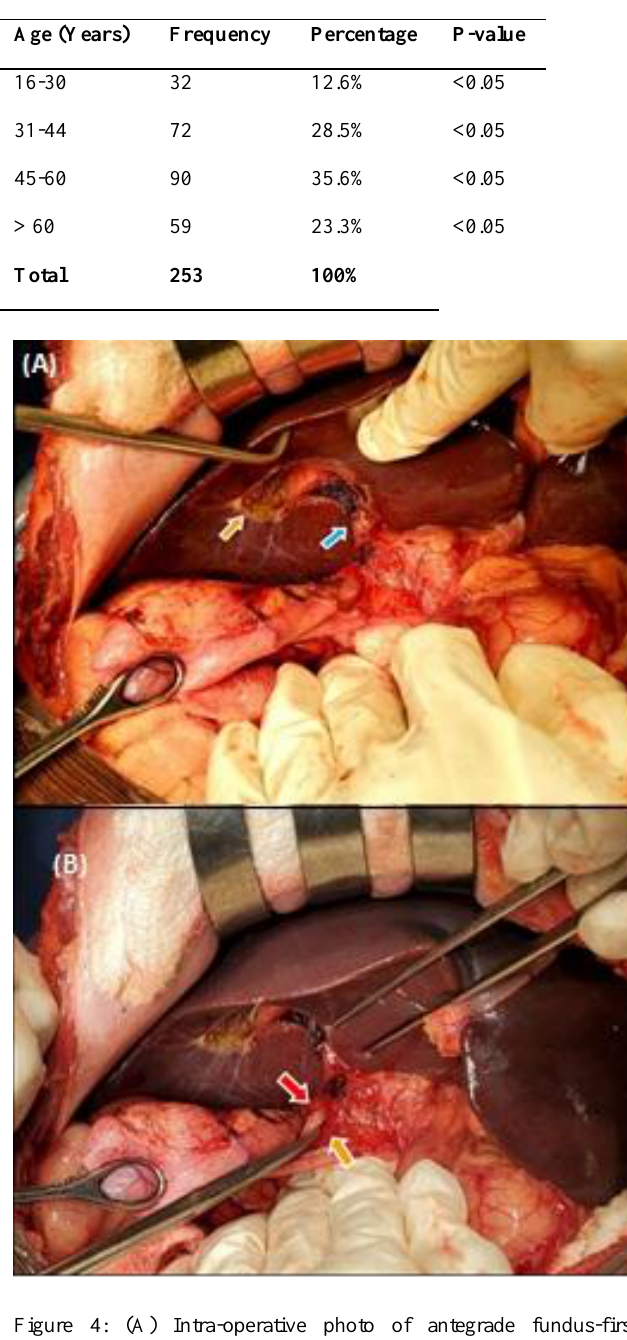
Table 1: Age distribution of difficult open cholecystectomy